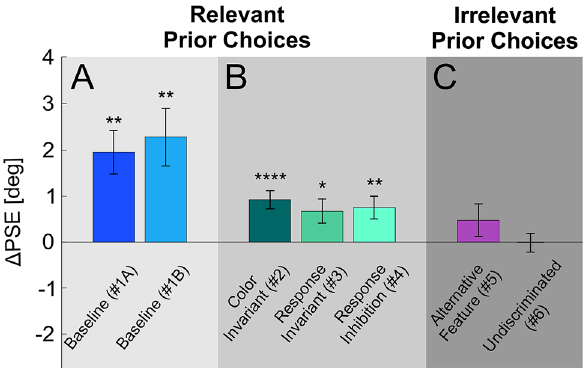
Figure 4. Prior effects across experimental conditions. The PSE difference between left and right prior types (ΔPSE = PSE Left_priors − PSE Right_priors ) is presented per condition (mean ± SEM). Condition names are presented below the bars (Condition number in parenthesis). Significant shifts are seen for: ( A ) the Baseline conditions (blue shades), and ( B ) control conditions in which the task for the prior stimuli was relevant to the test task (green shades). But, not for ( C ) conditions in which the task for the prior stimuli was irrelevant to the test task (pink shades). * p < 0.05, ** p < 0.01, **** p <